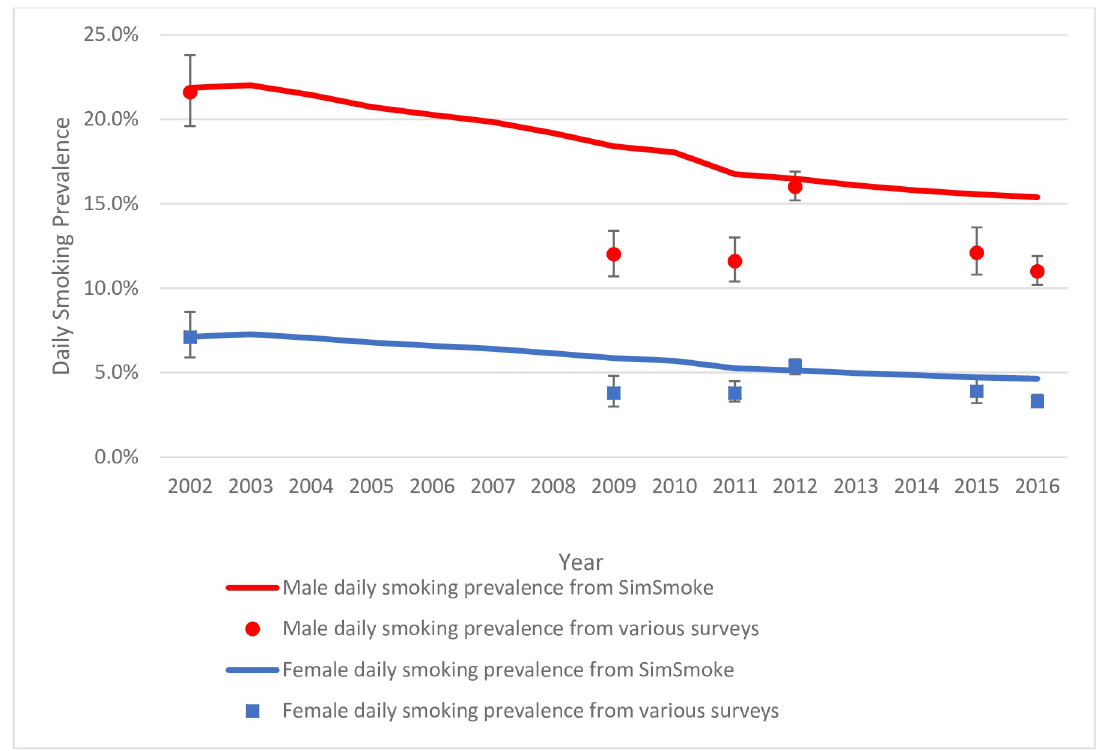
Fig 1. Validation of daily smoking prevalence, ages 15–65 by gender, from Mexico SimSmoke and various national surveys, � 2002– 2016. � The survey point estimates (indicated by dots) and 95% confidence intervals were obtained from the National Addictions Survey (ENA) in 2002 and 2011, the Global Adult Tobacco Survey (GATS) in 2009 and 2015, the National Health and Nutrition Survey (ENSANUT) in 2012, and the National Survey of Drugs, Alcohol, and Tobacco Consumption (ENCODAT) in 2016.